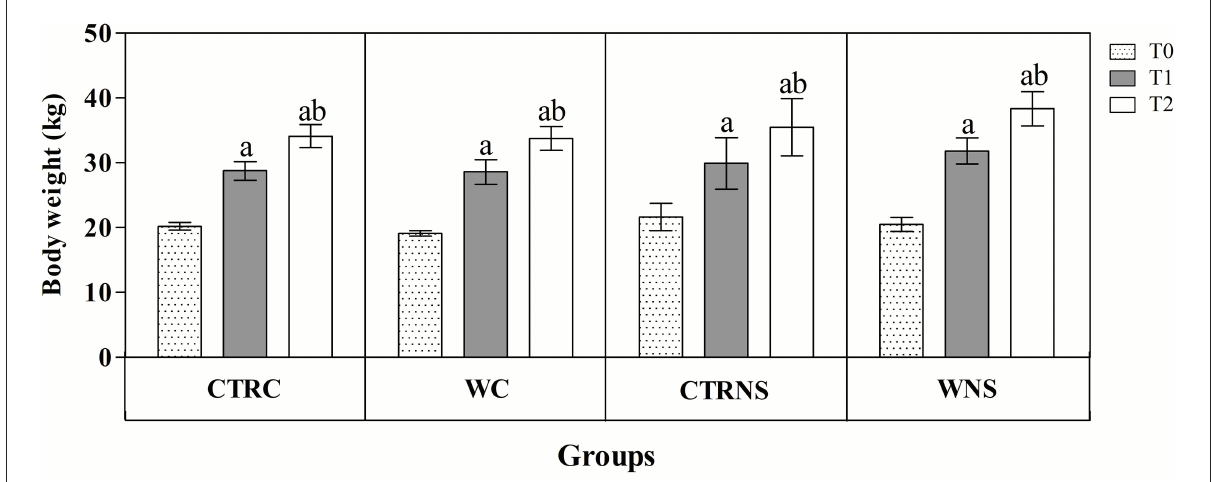
FIGURE1 Mean values ± standard error of the mean ( ± SEM) of body weight recorded from pigs belonging to control fed and experimental dietary supplemented crossbreed LxLW groups (CTRC and WC) and Nero Siciliano breed (CTRNS and WNS) before (T0), one (T1) and two (T2) months after the starting of diet supplemented with